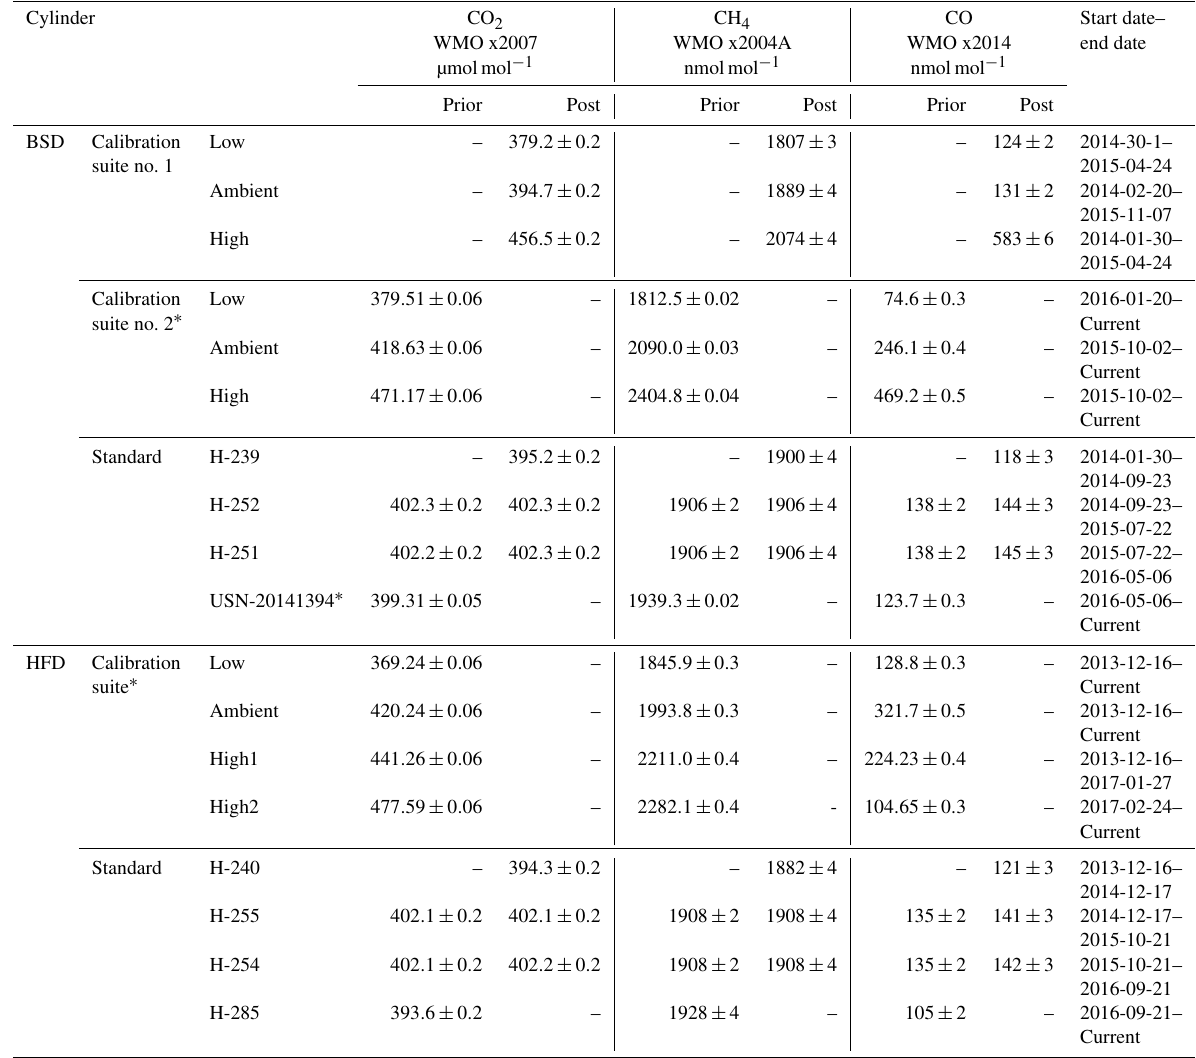
Table 3. CRDS calibration and standard cylinder mole fractions and usage start dates for the Heathfield (HFD) and Bilsdale (BDS) sites. Where available the mole fractions measured prior to and after deployment are given. Reported mole fractions from the WCC-EMPA, Dübendorf, Switzerland, are given as mean ± uncertainty. ∗ Mole fraction measurements from GasLab MPI-BGC, Jena, Germany, are given as mean ± 1 σ